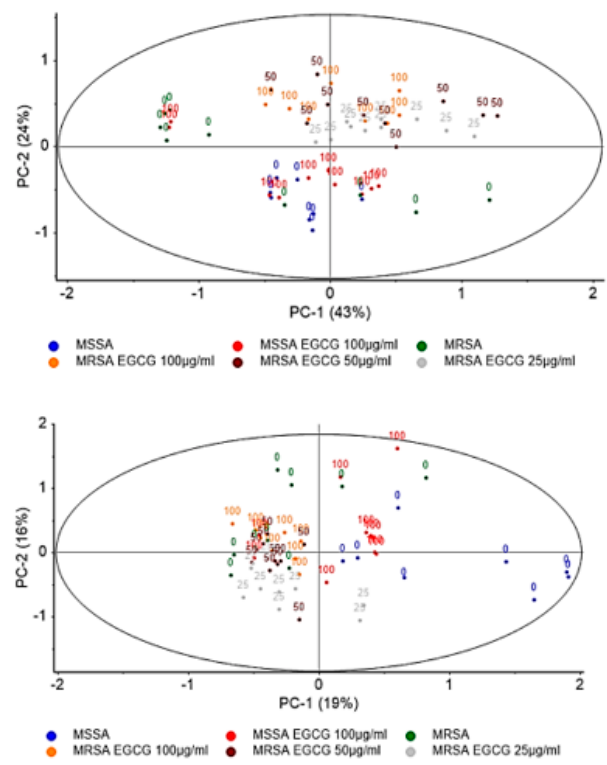
Figure 2. Spectra PCA from MRSA and MSSA incubated with diverse concentrations of EGCG after baseline and atmospheric correction and normalization ( A ) or based on normalized second-derivative spectra ( B ). Colors identify MRSA (green, orange, brown and grey) and MSSA (blue and red), while numbers refer to the EGCG concentration.